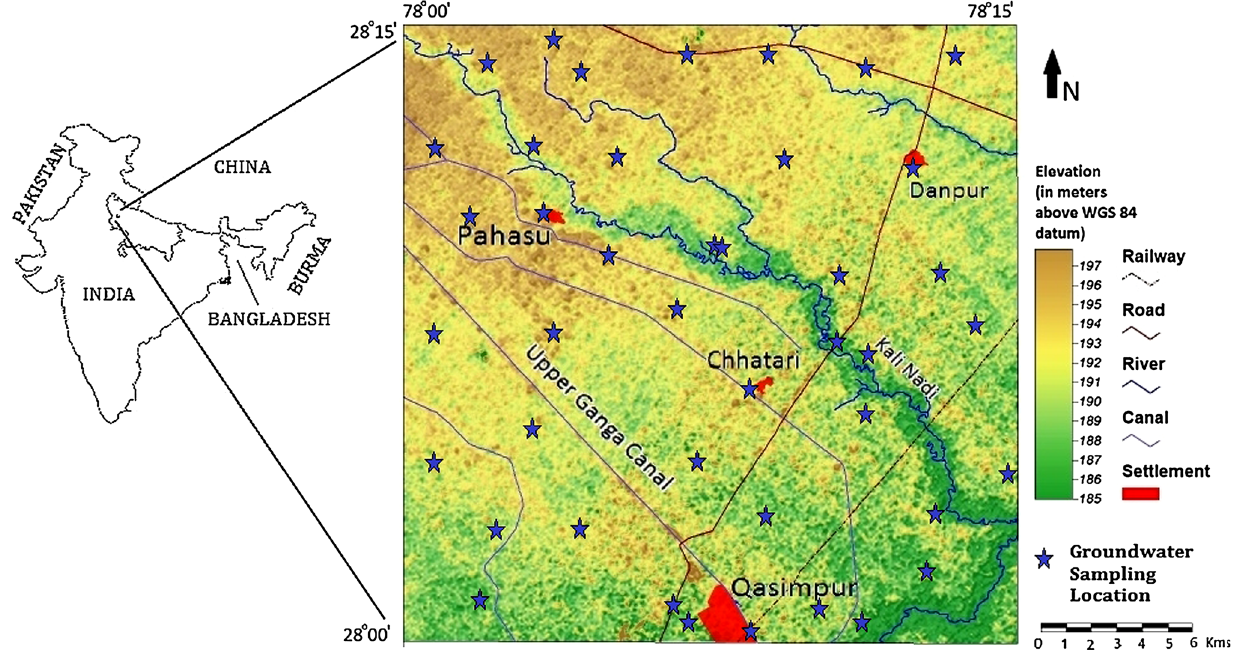
Fig. 1 Location of the study